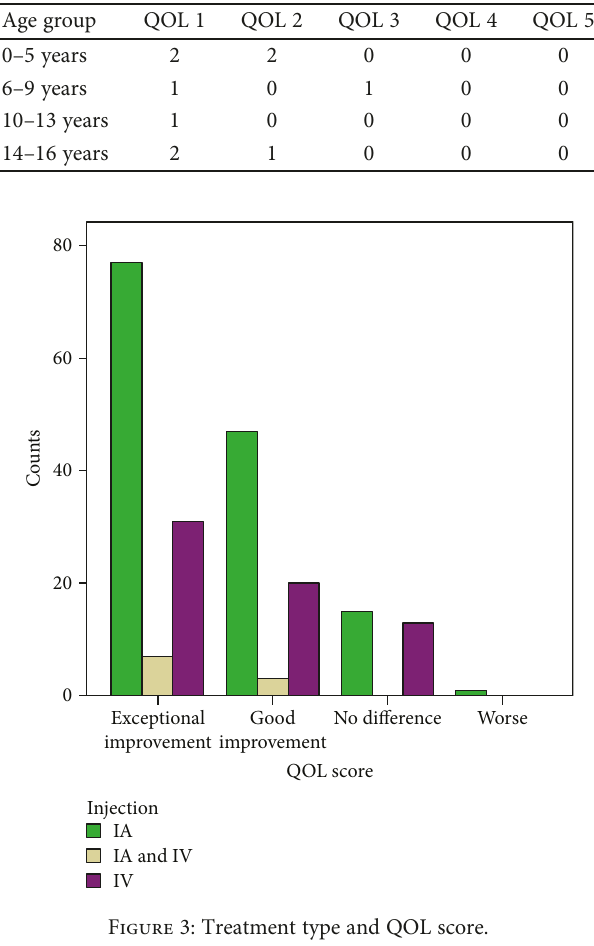
Figure 3: Treatment type and QOL